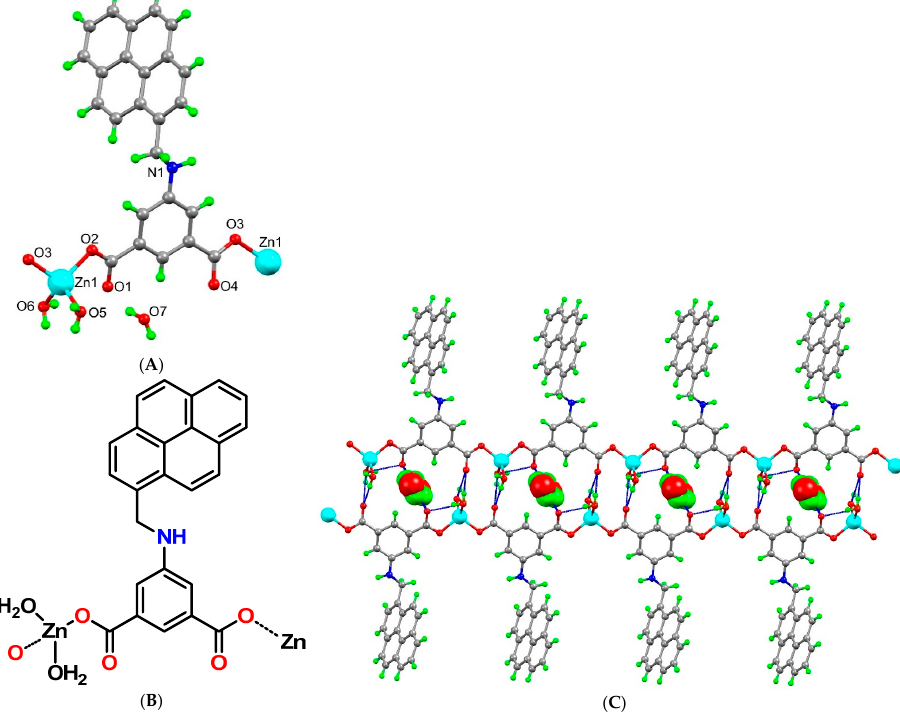
Figure 3. ( A ) Molecular structure of framework 1 . ( B ) Schematic representation of framework 1 . ( C ) Hydrogen bonded 1D chain of framework 1 .